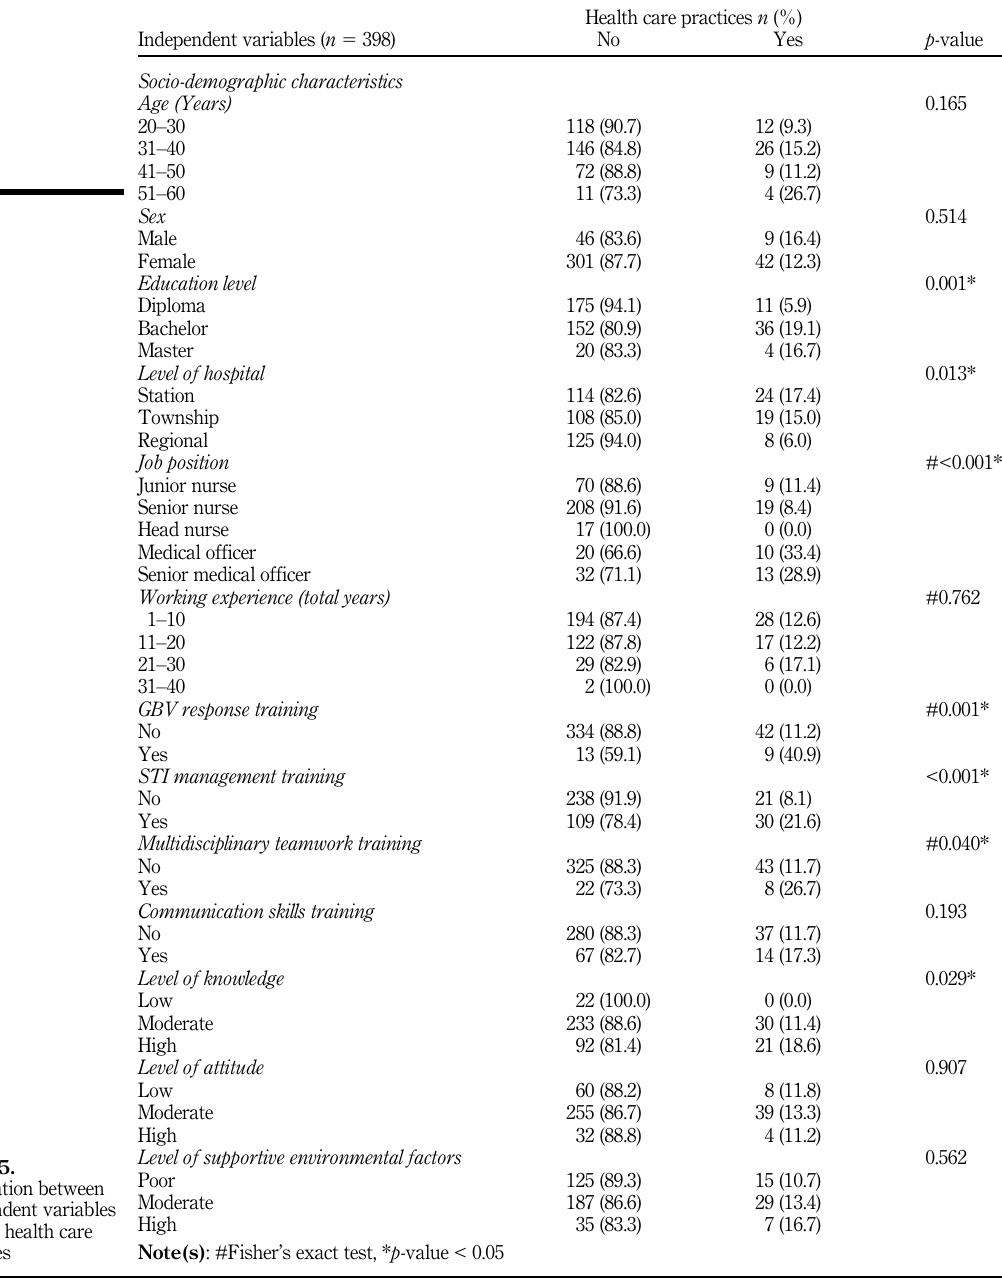
Table 5. Association between independent variables and the health care